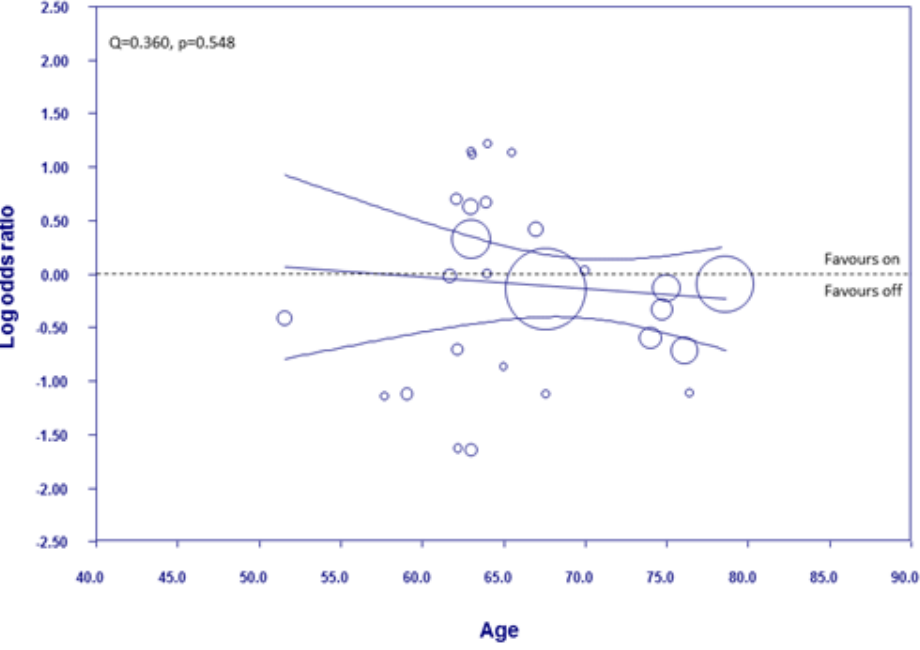
Fig. 6 – Weighted random-effects meta-regression analysis regressing the log odds ratio of mortality against age in the off-pump group. All other details as in Figure